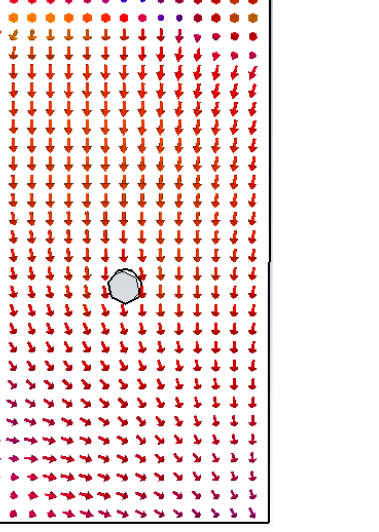
Figure 9. Electric field distribution on the top surface of the DR at ( a ) T = 0, and ( b ) T = t/4.